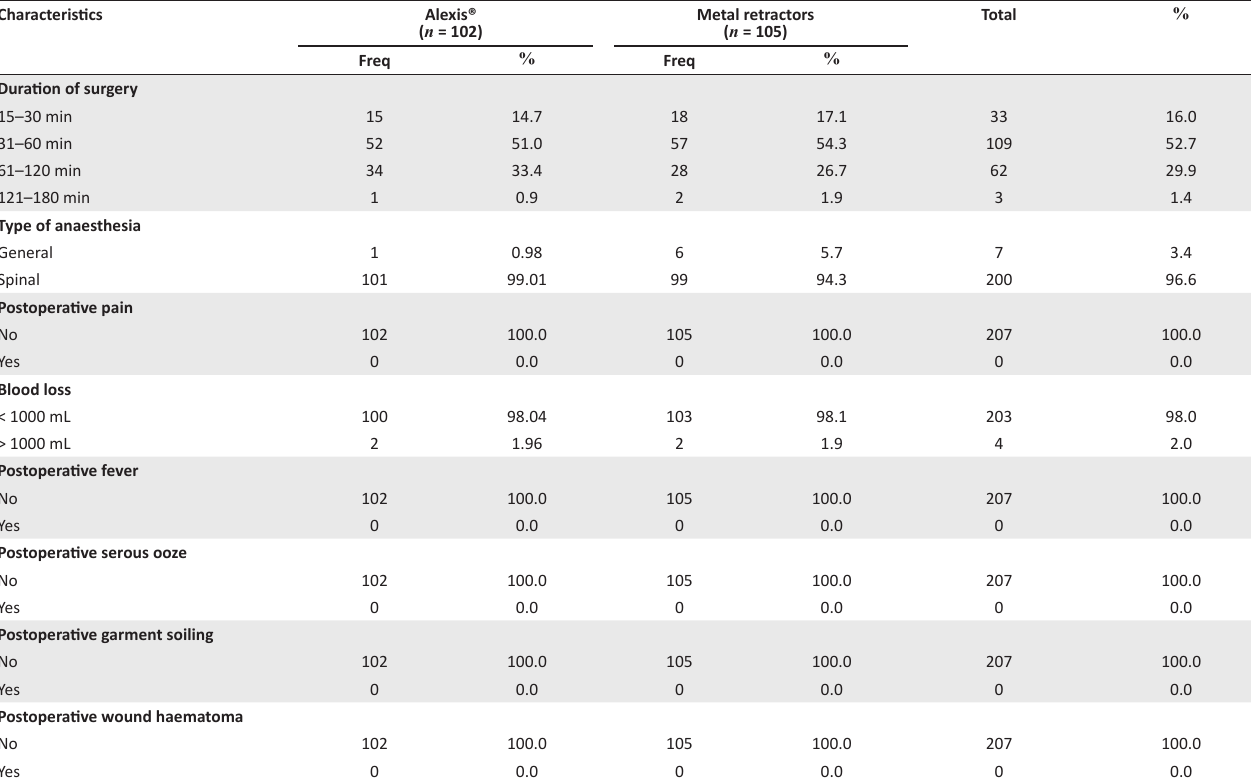
TABLE 1: Measurement of outcome parameters between the two groups ( n = 207). Characteristics